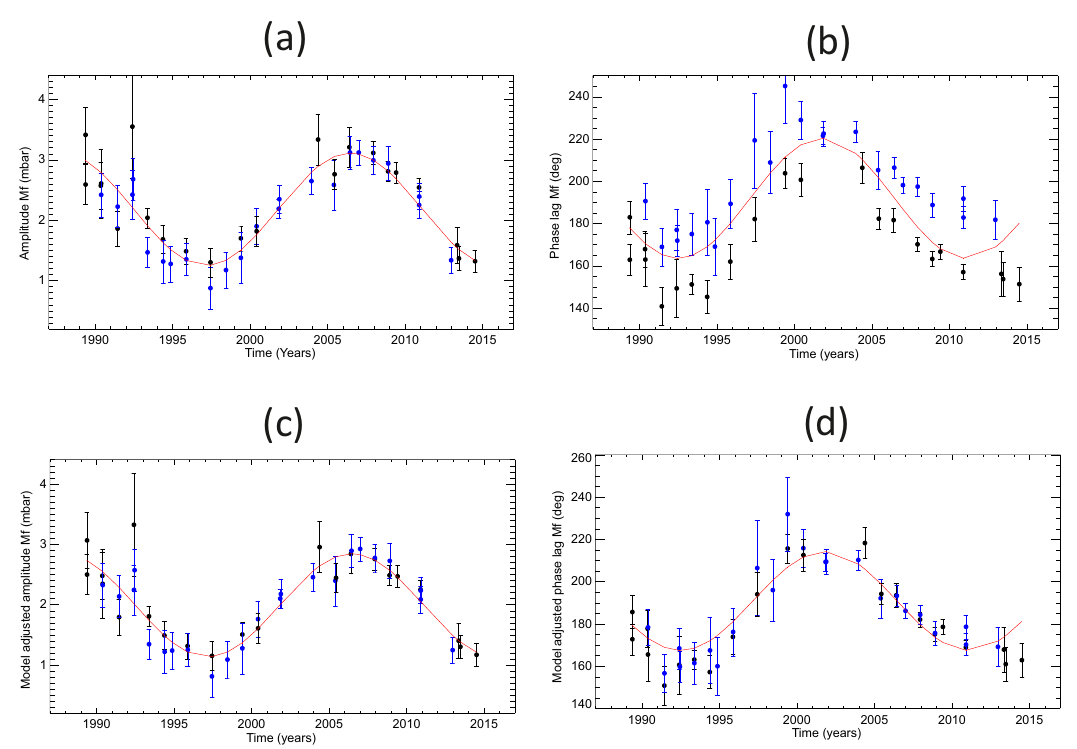
Figure 5. (a) Amplitude (mbar) and (b) phase lag (degrees) of Mf obtained from regression fits to the data from each BPR deployment described in Sect. 2 plotted versus the central date of the record. Error bars show 1 standard error in each parameter. Black and blue points indicate deployments north and south of 58 ◦ S, respectively. Red lines indicate fits with nodal variations as described in the text. Panels (c, d) are the same as (a, b) but with adjustments using the FES2014 model.